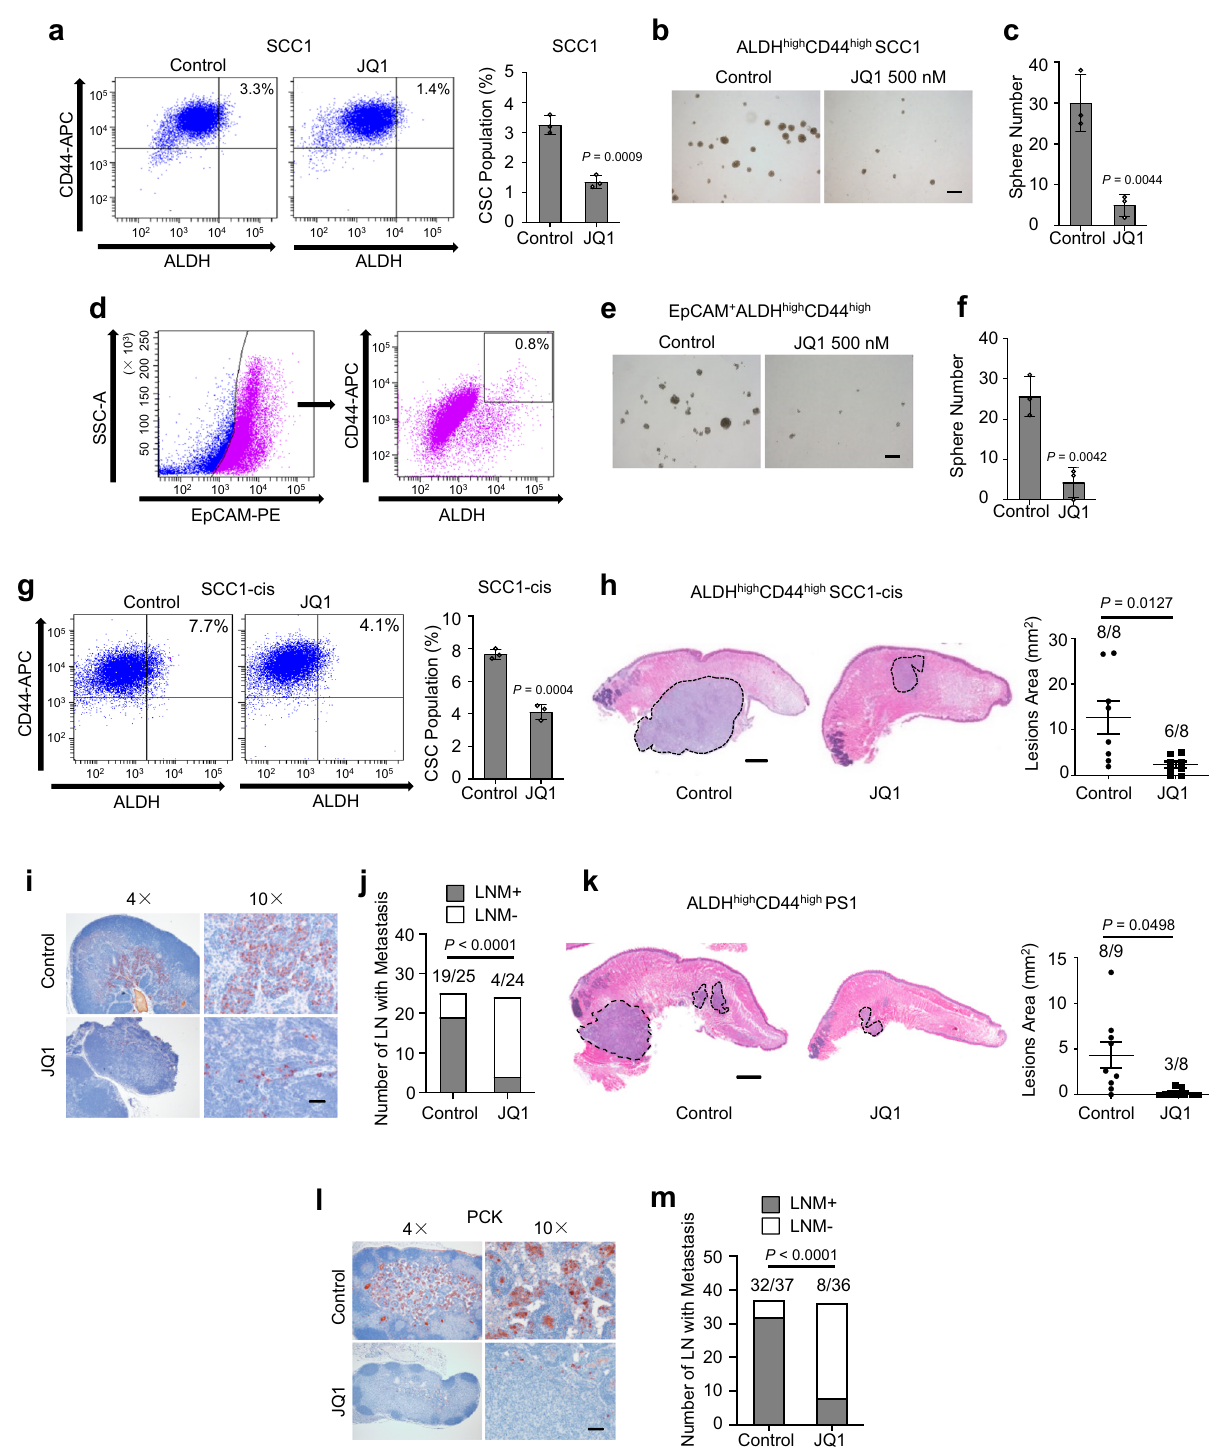
expressing dCas9, KRAB, and MeCP2 (VB190101-1021vwr), another expressing TSS. Enhancers were assigned to the RefSeq transcript whose TSS was nearest the the gRNAs (VB201112-1035tnv for MMP3 or VB201222-1082bxu for TP63). center of the enhancer. The intersect utility in bedtools was used to calculate the Lentivirus was generated and transduced into SCC1 cells. The transduced cells overlapping of the SEs with other SEs or enhancers. The minimum overlap were selected with hygromycin, blasticidin, and puromycin. RNA was extracted required is 1 bp. and qRT-PCR was performed. The gRNA sequences for the MMP3 and TP63 enhancers were as listed in Supplementary Table 3. CRISPRa and CRISPRi assay . For the CRISPRa assay, synergistic activation mediator (SAM) system was adopted 28 . Three lentivirus backbone plasmids that Luciferase reporter assay . TP63-SE and TP63-NEG fragments were constructed separately expressed dCas9-VP64 (VB170424-1009jup), MS2-P65-HSF1 into pLG4.23 luciferase reporter through standard PCR-clinging. The primer (VB170424-1011udy), and msgRNAs (gRNAs with the MS2 loops, VB201112- sequences for cloning TP63-SE were as listed in Supplementary Table 4. For 1035tnv for MMP3 or VB201112-1038gcn for TP63) were constructed by Vec- luciferase assay, SCC1 cells were plated in 12-well plates at 40 – 50% con fl uence. torBuilder. For the CRISPRi assay, two lentiviral plasmids were constructed, one NATURE COMMUNICATIONS| (2021) 12:3974